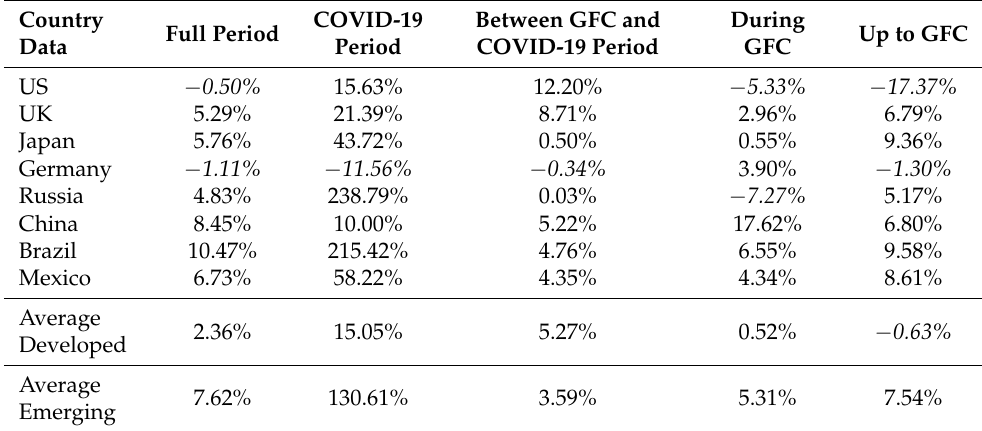
Table 4. Fama French five-factor model—results of cost of equity calculations for developed and emerging countries; negative values in italics.